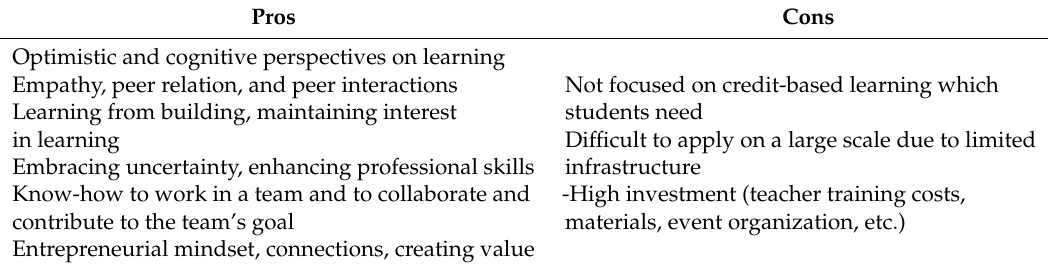
Table 12. Pros and cons of the PBL approach compared to a community-based